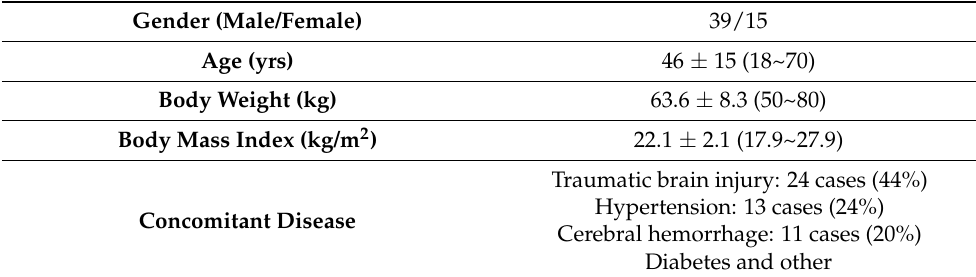
Table 1. Baseline characteristics of